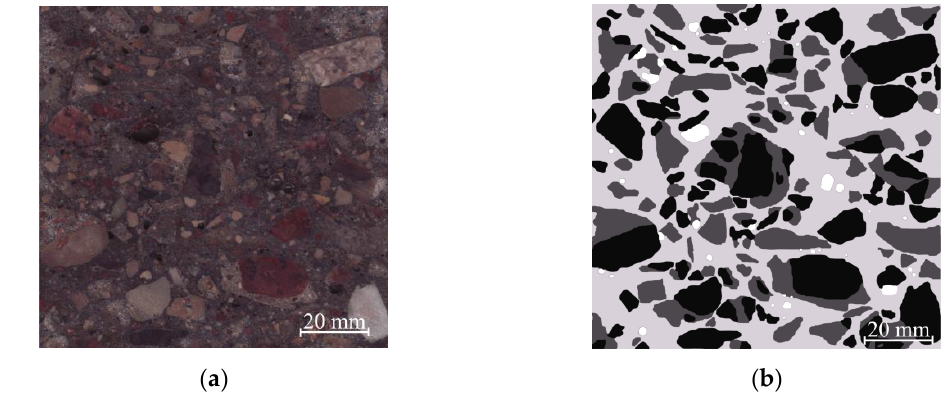
Figure 8. View of concrete sample CW2, ( a ) scanned; ( b ) analyzed by employing computer graphic software: white colored is used to indicate pores; light gray—newly created cement stone with fine aggregate; dark gray and black—concrete waste (dark gray—cement stone with fine aggregates and black—coarse aggregates).